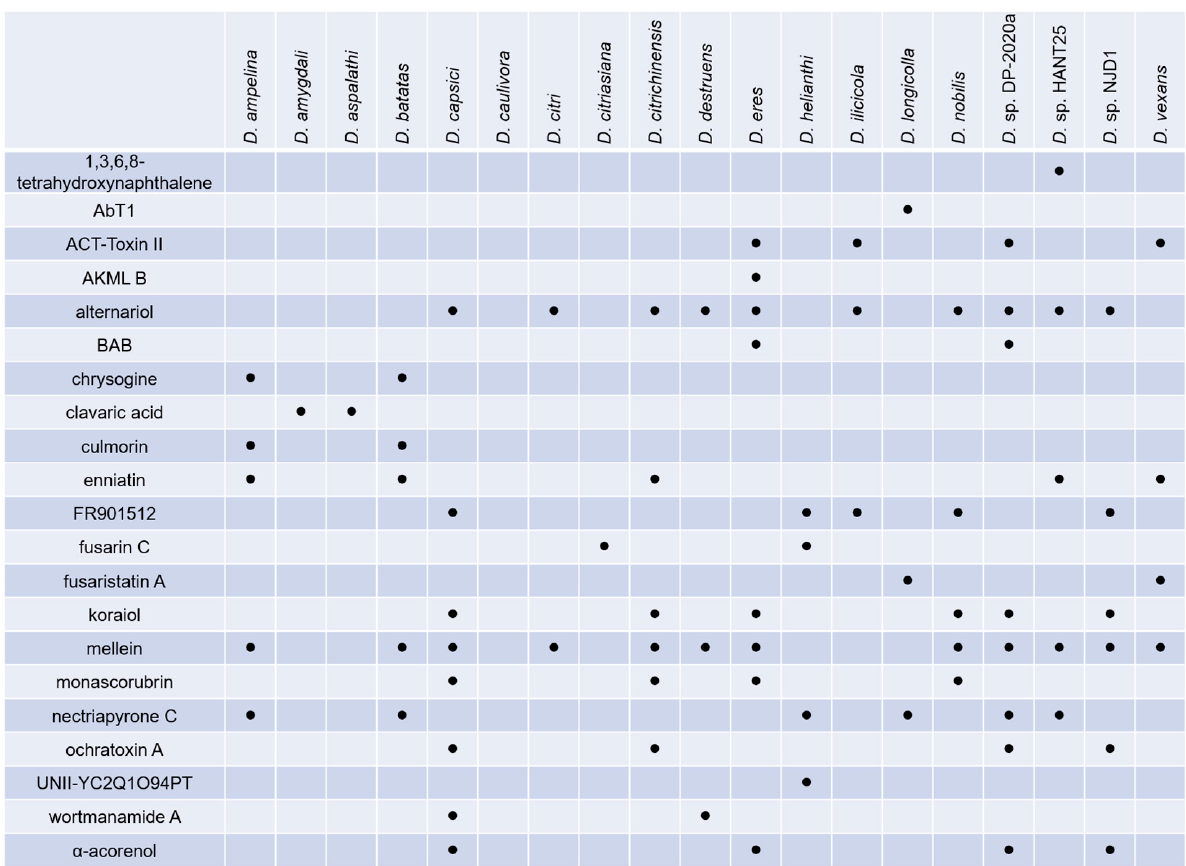
Figure 12. The number ( y -axis) and type of secondary-metabolite BGCs in Diaporthe strains depos- ited in the NCBI database.